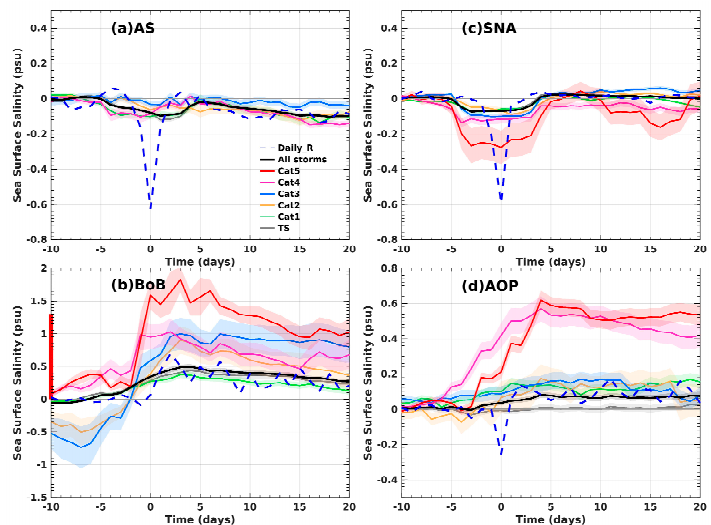
Figure 15. Lagrangian composite SSS anomaly relative to the reference SSS during the period 2011–2019, from Aquarius and SMAP seven/eight-day running mean daily data (L3) for the ( a ) AS, ( b ) BoB, ( c ) SNA, and ( d ) AOP. The dashed blue lines are Lagrangian composite SSS response for all storms calculated with Aquarius and SMAP swath daily data (L2) with high surface wind raised SSS removed. The range of y-axis is 1.3 psu for ( a ), ( c ) and ( d ) while 3.5 psu for ( b ). For reference, the 0 to 1.3 psu range is marked in red line in panel ( b ).